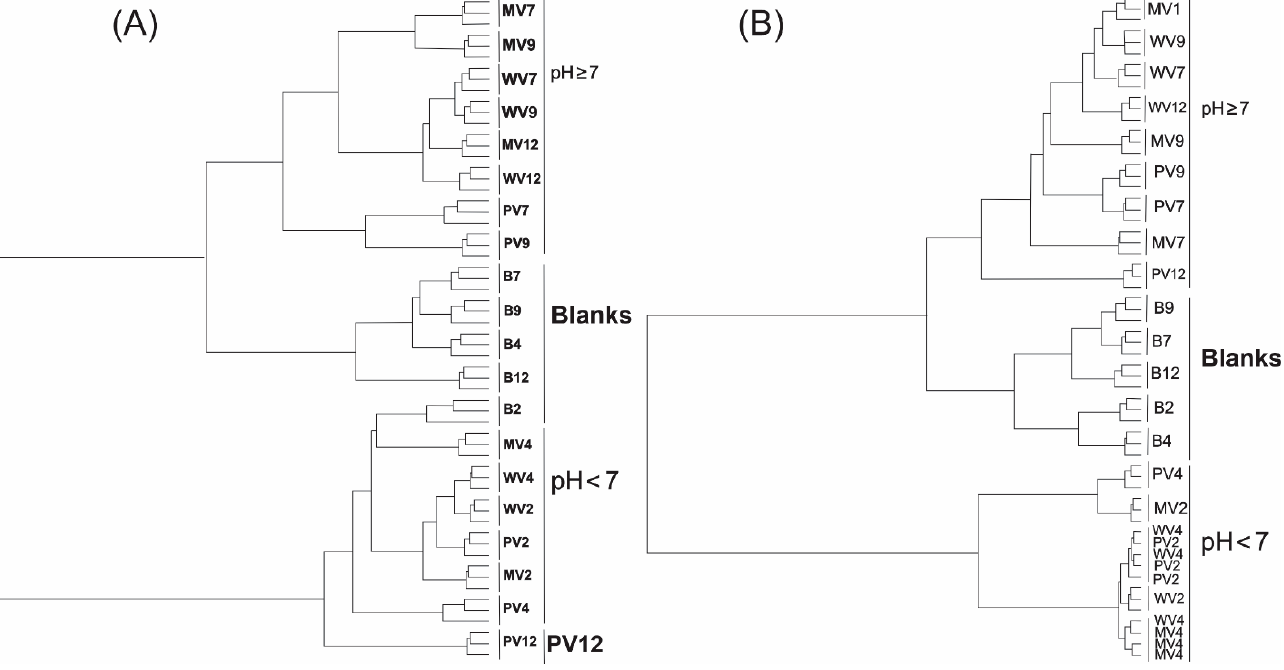
Figure 4. Hierarchical clustering analysis (HCA). Dendrograms were generated by Euclidian distancing and the Ward grouping algorithm for (A) samples obtained in positive acquisition mode and (B) samples obtained in negative acquisition mode.